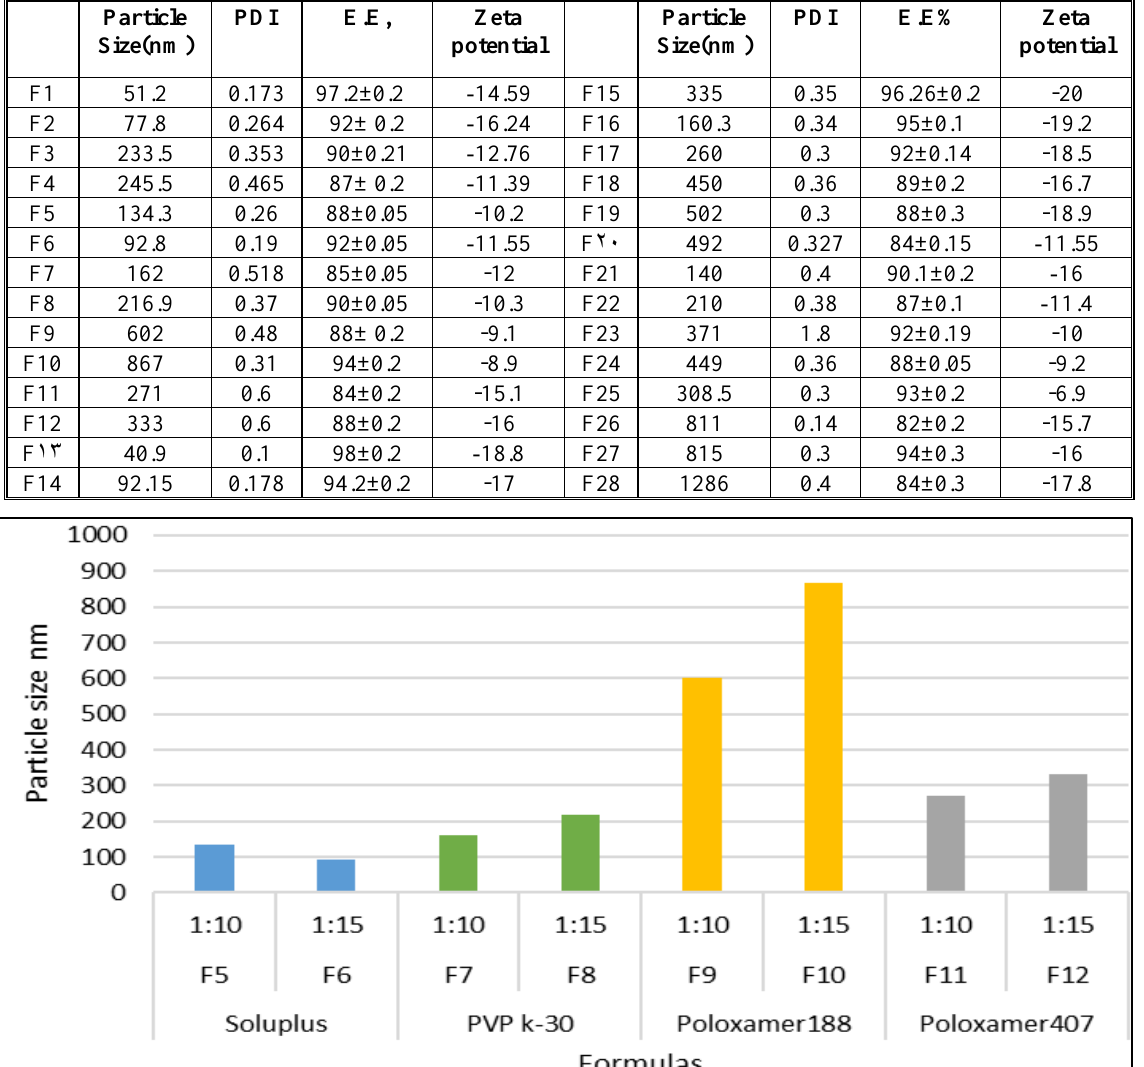
Figure 2. The effect of solvent/antisolvent on the particle size features on the prepared risperidone